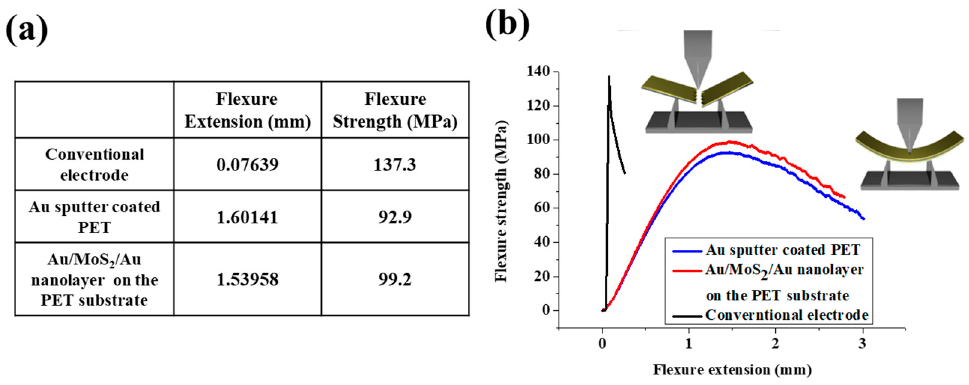
Figure 6. ( a ) Table of results for flexibility test and ( b ) flexure graphs of conventional electrode, Au sputter coated PET, Au / MoS 2 / Au nanolayer on the PET